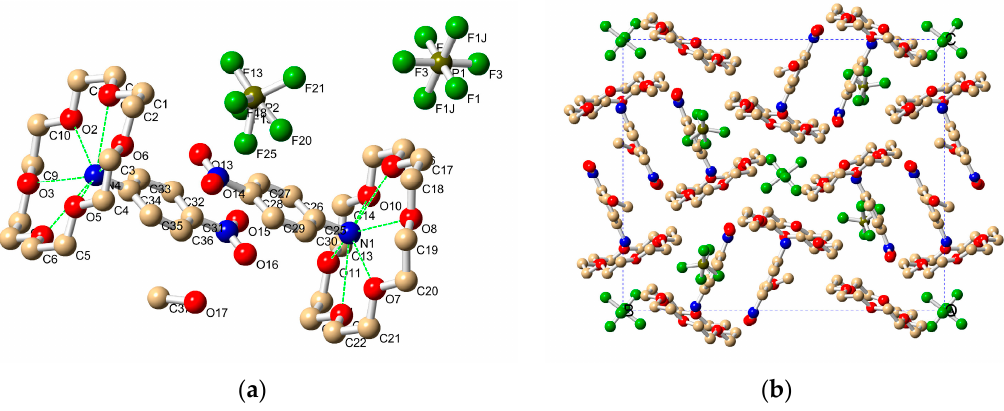
Figure 3. Asymmetric unit ( a ) and packing diagram ( b ) of crystal 2 viewing along the a -axis at 100 K and 296 K. Most of the hydrogen atoms on the carbon atoms are omitted for clarity.